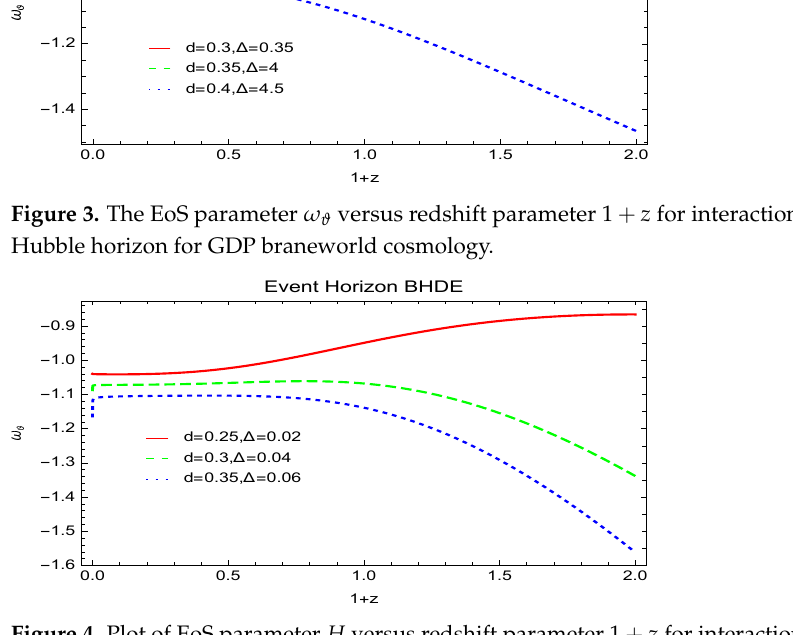
Figure 4. Plot of EoS parameter H versus redshift parameter 1 + z for interaction BHDE model with event horizon for GDP braneworld